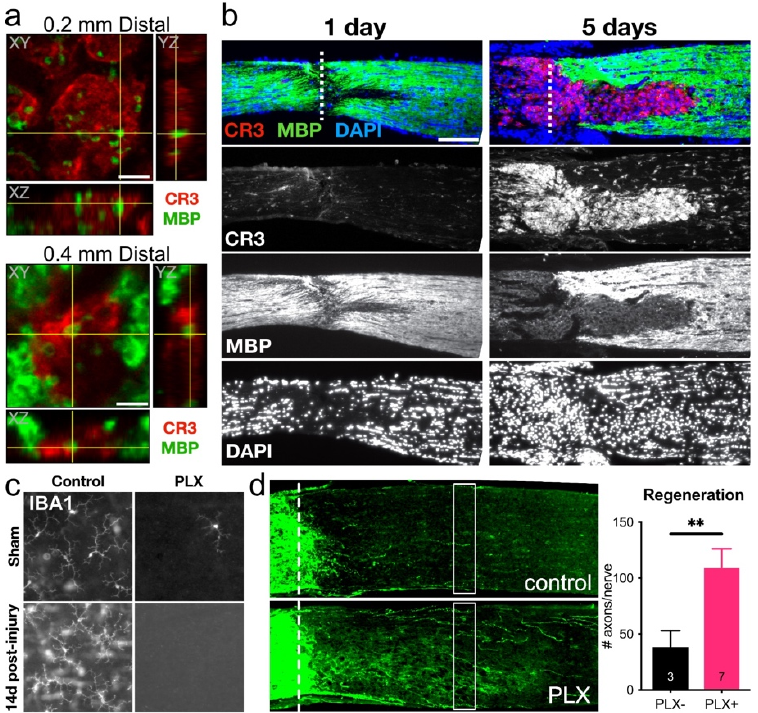
Figure 6. Phagocytic microglia/monocytes alter the local environment of the injury site and modulate axon regeneration. ( a ) Single confocal planes with orthogonal views of myelin basic protein (MBP) debris inside CR3+ cells. Images are from 0.2 and 0.4 mm distal to the injury site at 14 DPI [44]. ( b ) CR3+ microglia and monocytes expand within the site of injury (dotted line) from 1 to 5 days after crush, resulting in a progressive clearance of MBP from the distal optic nerve, allowing for uninhibited axon regeneration [44]. ( c ) Treatment with CSF1R inhibitor, PLX5622 (PLX) results in efficient clearance of IBA1+ microglia from the retina, which is maintained by 14 days after ONI (14d post-ONI). ( d ) Microglia deletion enhances the number of GAP43+ (green) axons regenerating past the crush site (dotted line). Right: Quantitation of regenerating axons 0.5 mm distal to the injury site ( ☐ ); mean ± s.e.m, n = optic nerves, **, p ≤ 0.01 by t -test [44].